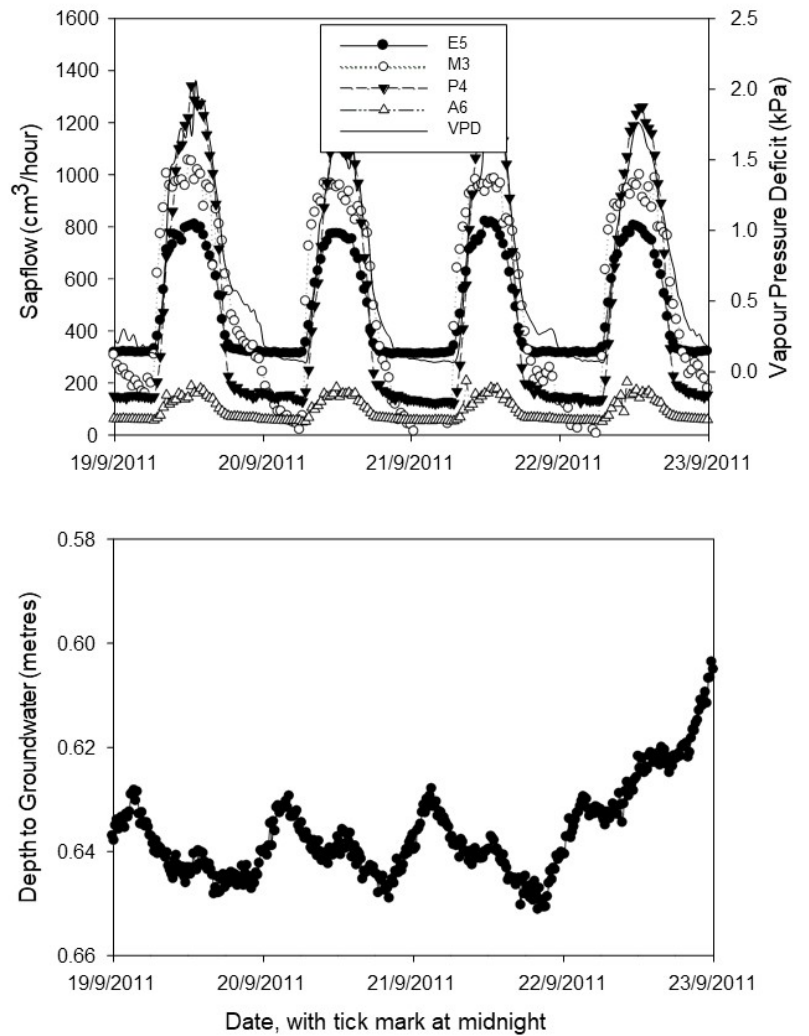
Figure 3. Diurnal fluctuations in sap flow for 4 of the trees monitored vapor pressure deficit and depth to groundwater in September 2011.